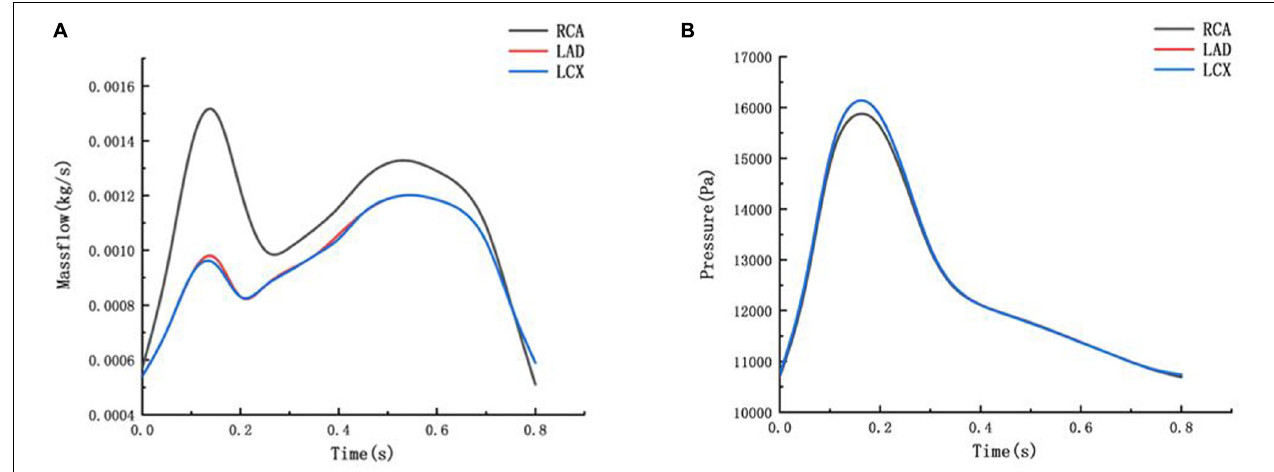
FIGURE 3 | Mass flow and Pressure boundary (A) mass flow boundary of inlet (B) pressure boundary of outlet.